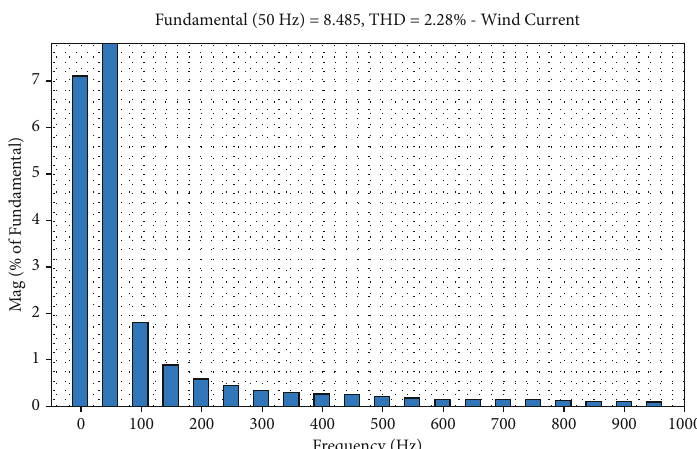
Figure 37: THD values of wind